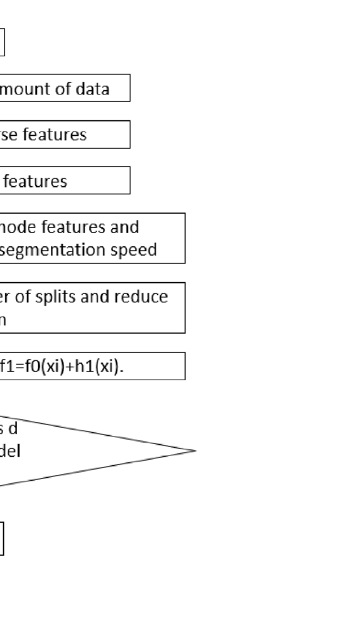
Figure 1. The LightGBM generation